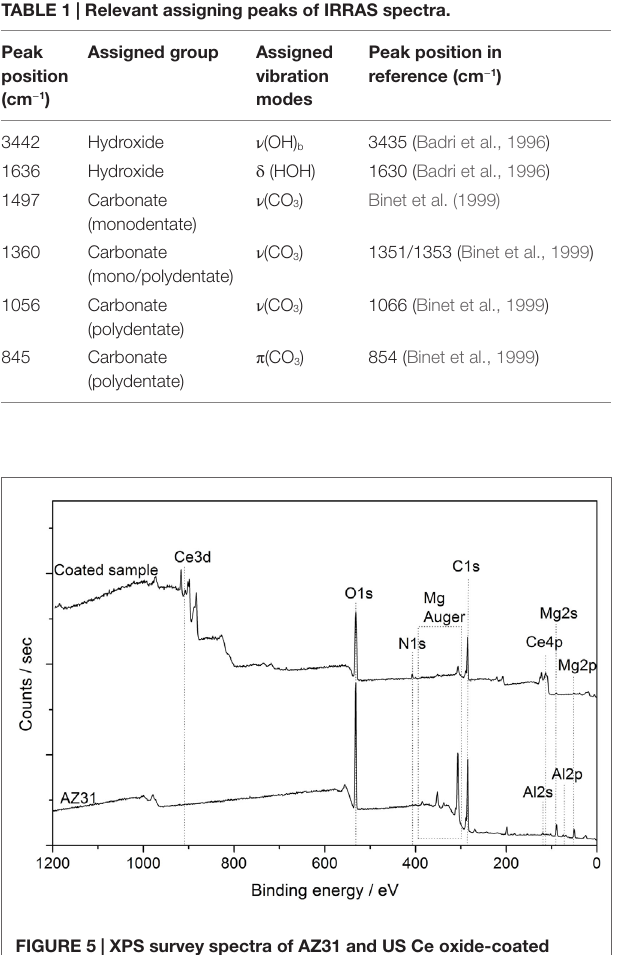
FigUre 5 | XPs survey spectra of aZ31 and Us ce oxide-coated aZ31 .